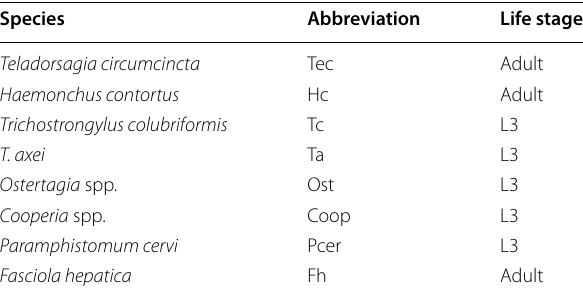
Table 7 Common livestock helminths and life stages used for DNA extraction for specificity panel